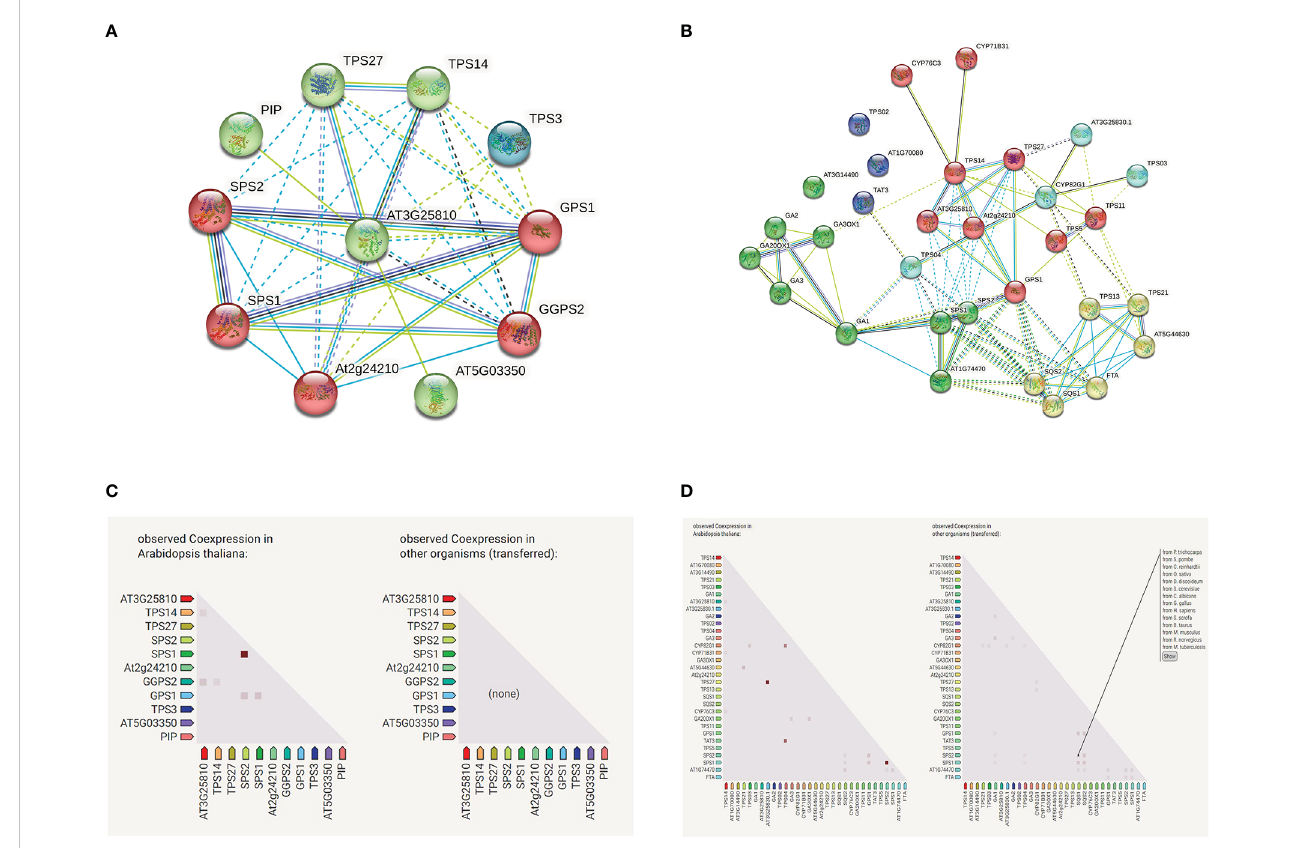
FIGURE 11 GhTPS proteins interaction network. (A) GhTPS 42 protein interaction network. (B) Interaction network of GhTPS proteins. (C) GhTPS42 gene co- expressed. (D) Gene co-expression of the GhTPS gene family. Note: The homologous gene of GhTPS42 in A thaliana is